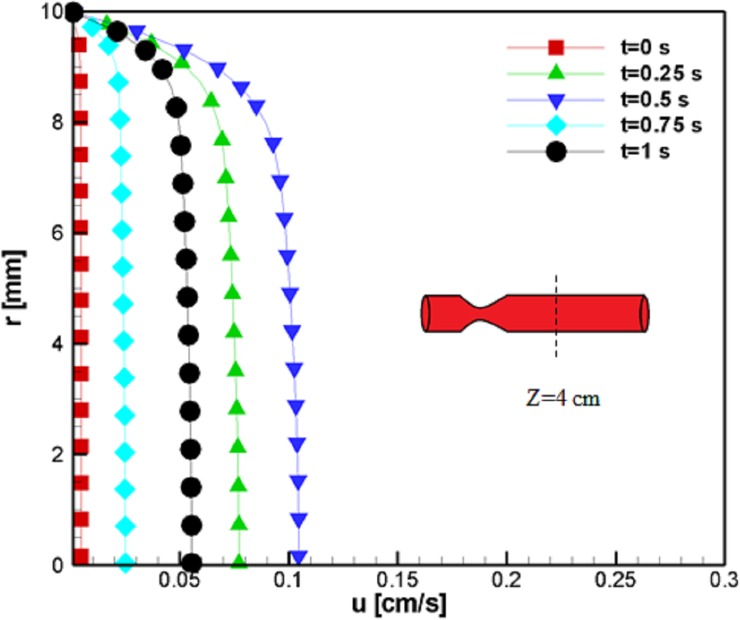
Profile of the velocity in the axial direction at z = 4 cm for the case without Joule heating at five different time instances, Lvessel = 7 cm, Rvessel = 1 cm and fifty percent stenosis.